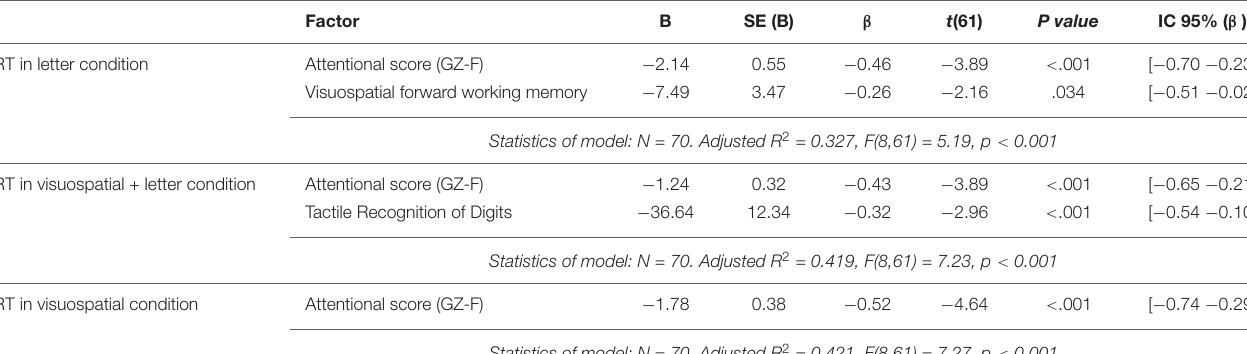
TABLE 3 | Summary of linear multiple regression analysis for the neuropsychological Scores predicting the reaction time of the last block (block 6) in the letter condition (upper table), the Visuospatial + letter condition (middle table) and the Visuospatial condition (lower